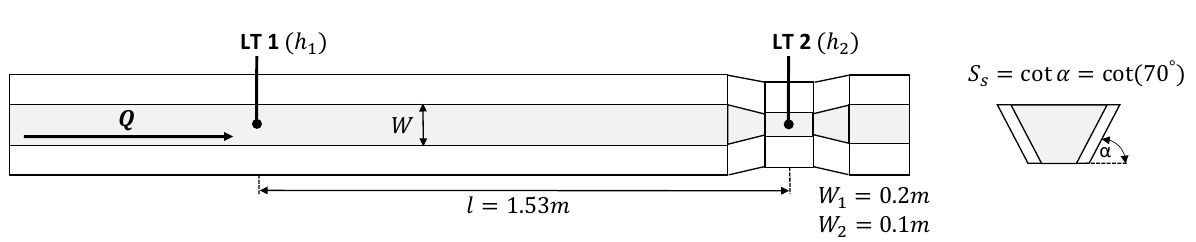
Figure 1: Top view and end view of the Venturi channel. The placement of level sensors LT 1 and LT 2 (at the two collocation points) are also shown